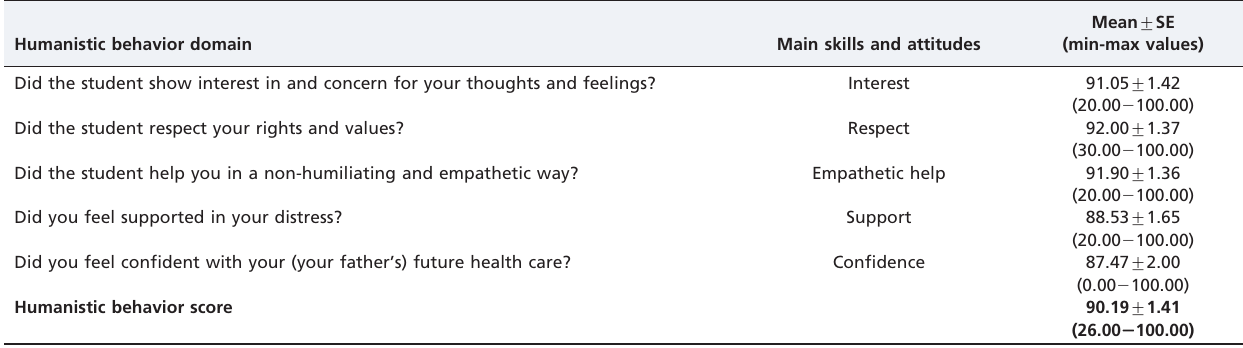
Table 4 - Patient safety checklist: humanistic behavior domain with the related competency and student scores. Humanistic behavior domain